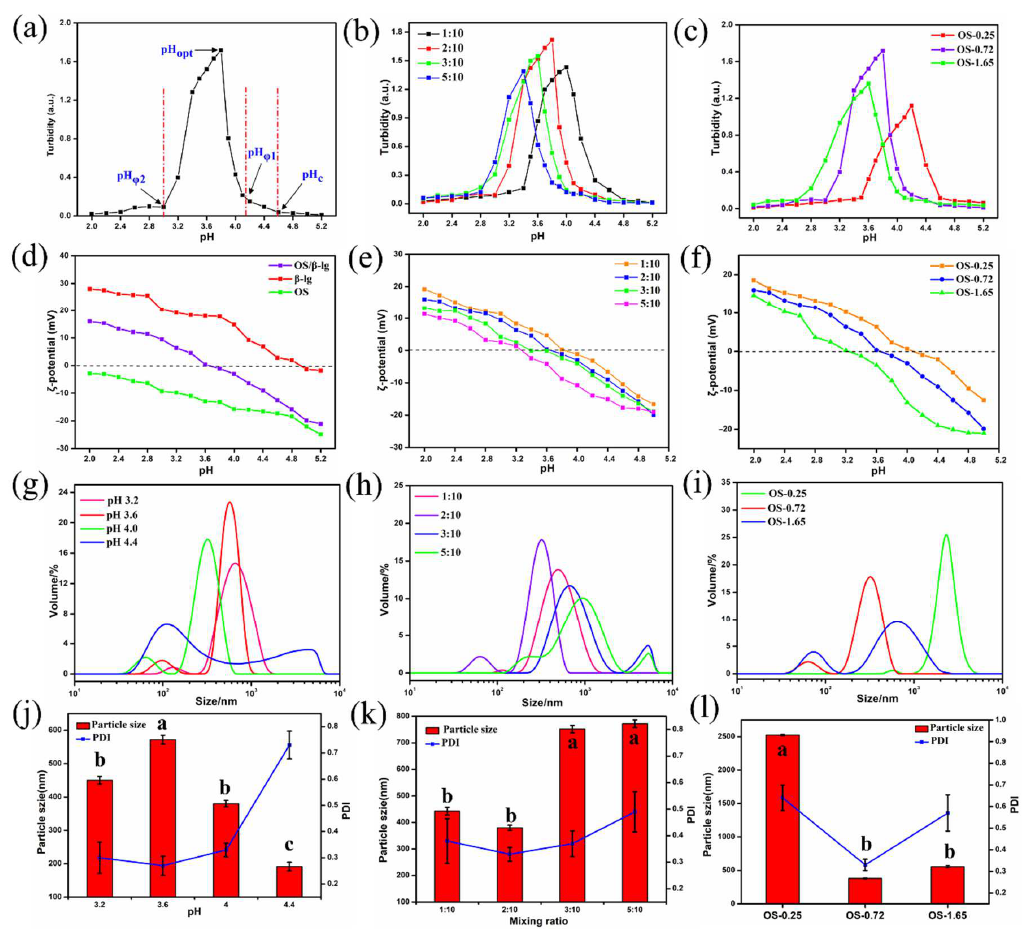
Figure 2. Turbidity curve ( a – c ) and zeta potential ( d – f ) of OS/β-lg complex dispersions at different pHs and OS/β-lg mixing ratios (( a ): OS-0.72, OS/β-lg mixing ratio of 2:10; ( b ): OS-0.72; ( c ): OS/β-lg mixing ratio of 2:10); and particle size distribution ( g – i ), average size, and PDI ( j – l ) of OS/β-lg complex coacervates at different pHs, DSs, and OS/β-lg mixing ratios. Bars with different letter superscripts are significantly different at p < 0.05.